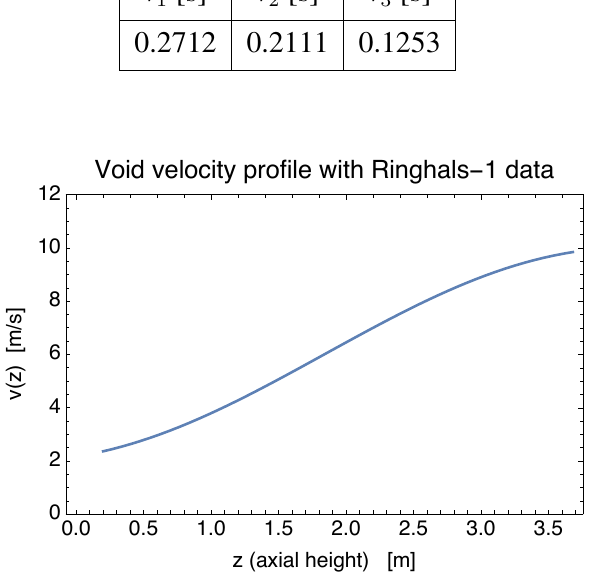
Figure 5: Void velocity profile obtained from Ringhals